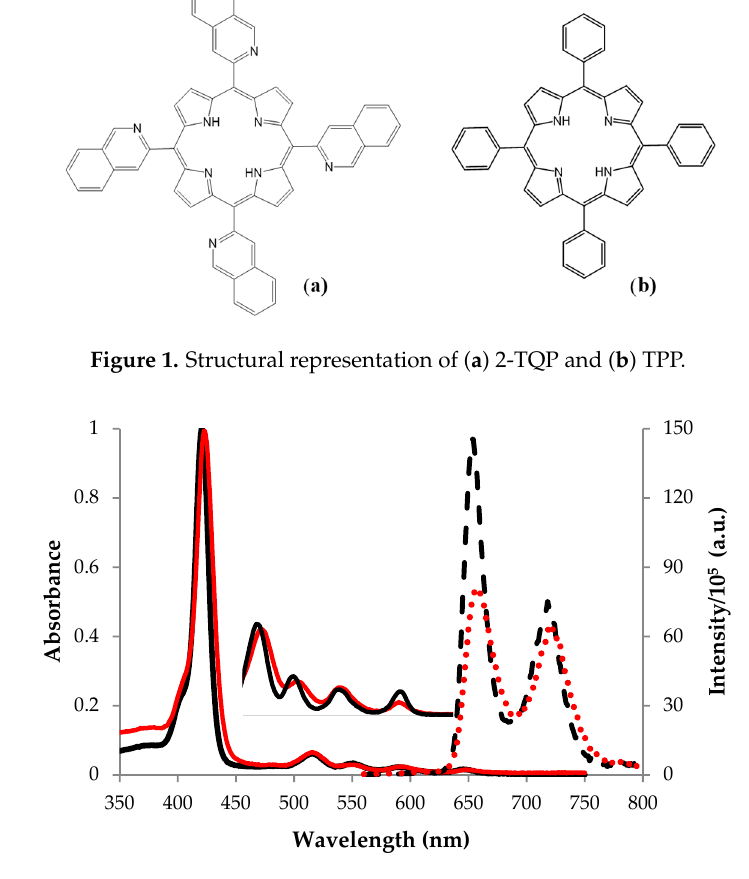
Figure 1. Structural representation of ( a ) 2-TQP and ( b ) TPP.